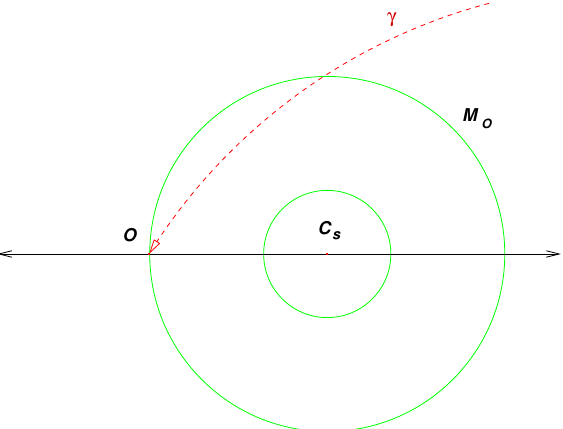
Figure 1. LTB plane with t = constant and ϕ = 0. The slices M O , observer, and another arbitrary slice are plotted, as well as the symmetry centre C s . The discontinuous line γ represents the null geodesic of a photon arriving at the observer, O , at time t 0